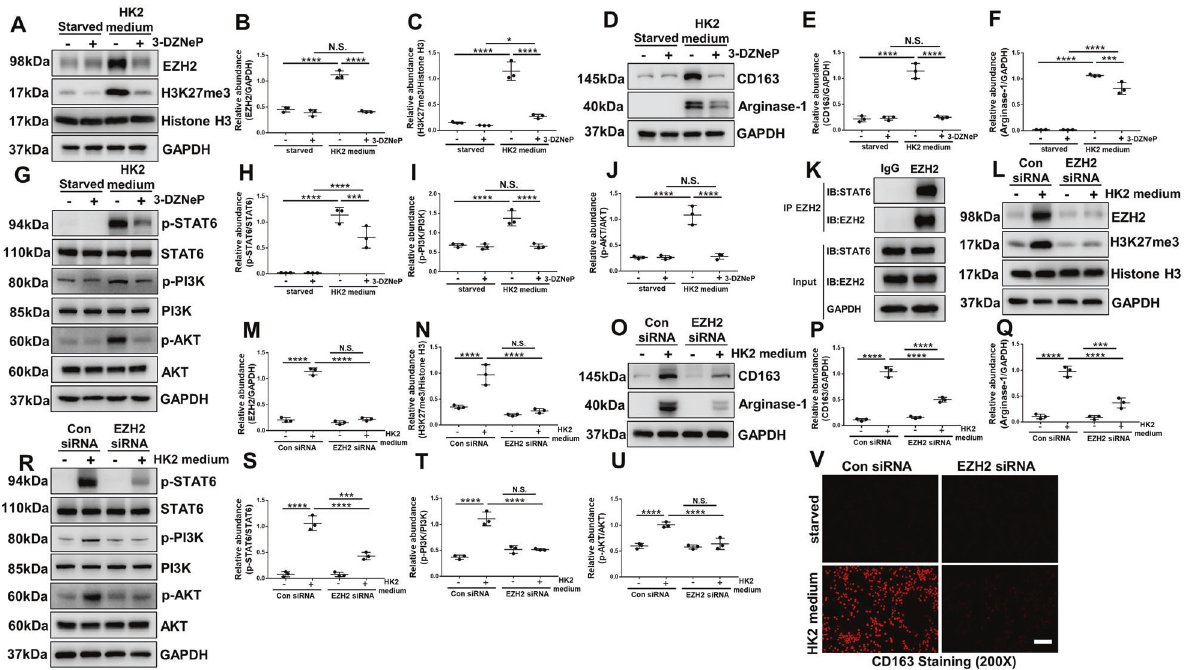
Fig. 7 Genetic or pharmacological depletion of EZH2 inhibits M2 macrophage polarization through STAT6 and PI3K/AKT pathways in Raw264.7 cells. Starved Raw264.7 cells were cultured with or without 10% (vol/vol) pre-collected cell culture media from HK2 cells treated with 0.5 mM H 2 O 2 in the presence of 3-DZNeP (5 μ M) for 24 h before cell harvesting. A Cell lysates treated with 3-DZNeP were subjected to immunoblotting analysis with antibodies against EZH2, H3K27me3, Histone H3, and GAPDH. B , C Expression levels of EZH2 and H3K27me3 were quanti fi ed by densitometry and normalized with GAPDH and Histone H3. D Cell lysates treated with 3-DZNeP were subjected to immunoblotting analysis with antibodies against CD163, Arginase-1, and GAPDH. E , F Expression levels of CD163 and Arginase-1